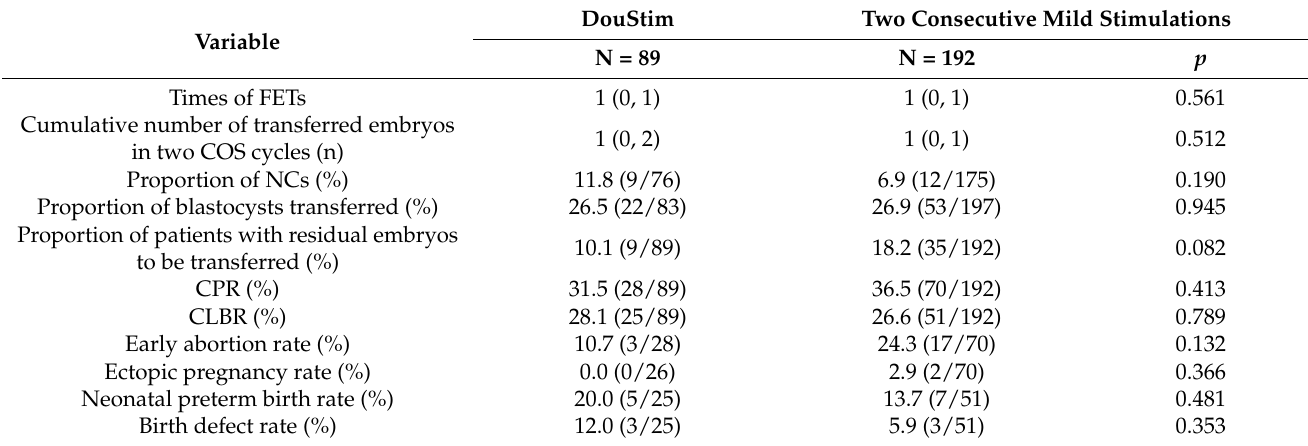
Table 3. Comparison of pregnancy outcomes between the DouStim group and the two consecutive mild stimulations group.